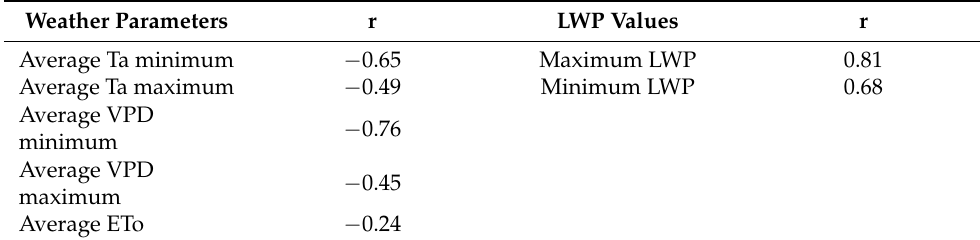
Table 4. Correlation coefficients between the yield and the weather parameters or the LWP (n =